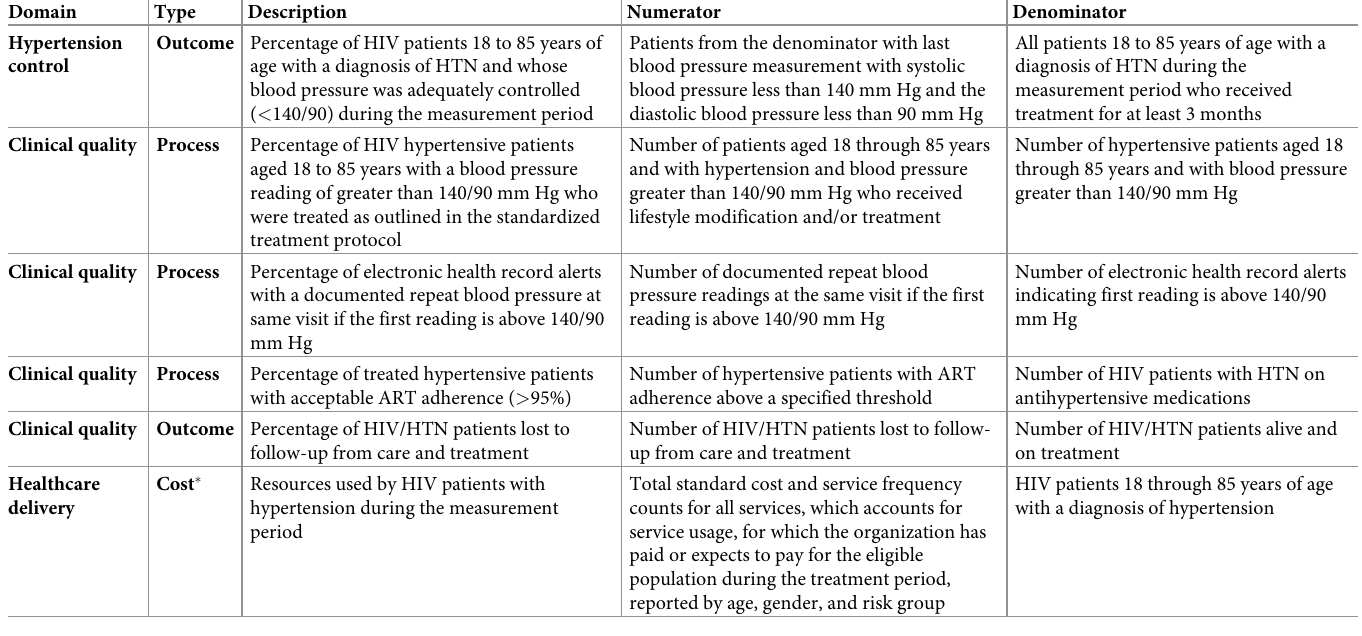
Table 2. Example core process and outcome indicators for an integrated hypertension/human immunodeficiency virus (HIV) clinical management program exam- ined at 6-month intervals.